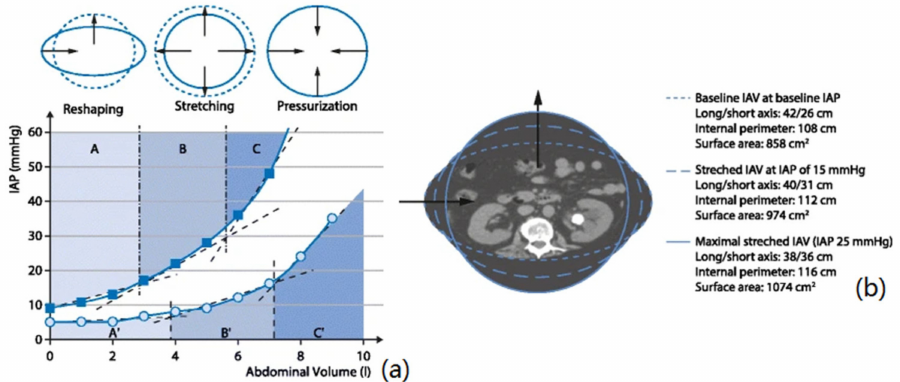
Figure 9. Evolution of intra-abdominal pressure (IAP) versus intra-abdominal volume (IAV) in two different subjects. ( a ) As shown in this figure, intra-abdominal hypertension (IAH) can be studied in three different stages known as reshaping, stretching, and pressurization. At the reshaping phase, slight IAP elevation results in relatively significant IAV increase; however, according to the abdominal compliance, the IAV increase versus IAP elevation is smaller in the stretching and pressurization phases, respectively. ( b ) Patients with an ellipse-shaped internal perimeter have a relatively high abdominal compliance; this is illustrated with the progression of the shape from ellipse (dotted line) at baseline to a sphere (solid line) at very high IAP obtained during laparoscopy. During increase in intra-abdominal volume (IAV) from baseline to stretched and maximal stretched IAV, the difference between the long and short axes of the ellipse decreases, while the internal perimeter and surface area increase. (Adapted from Malbrain et al. [16] with